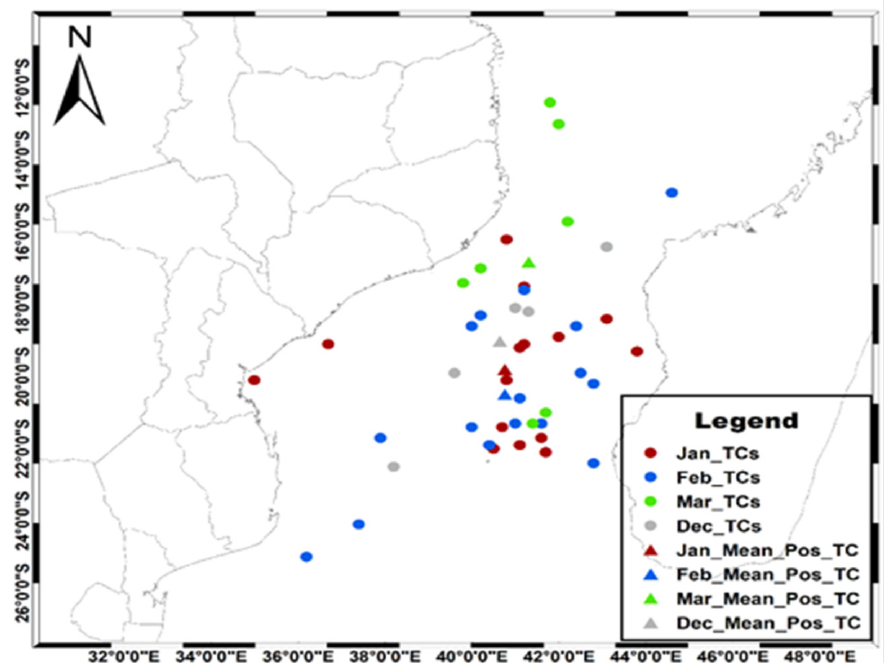
Figure 4. Geographical distribution of tropical cyclogenesis events over the MC during the 1979–2019 period. The colors distinguish the events by month (dots) and the monthly mean position is repre- sented by